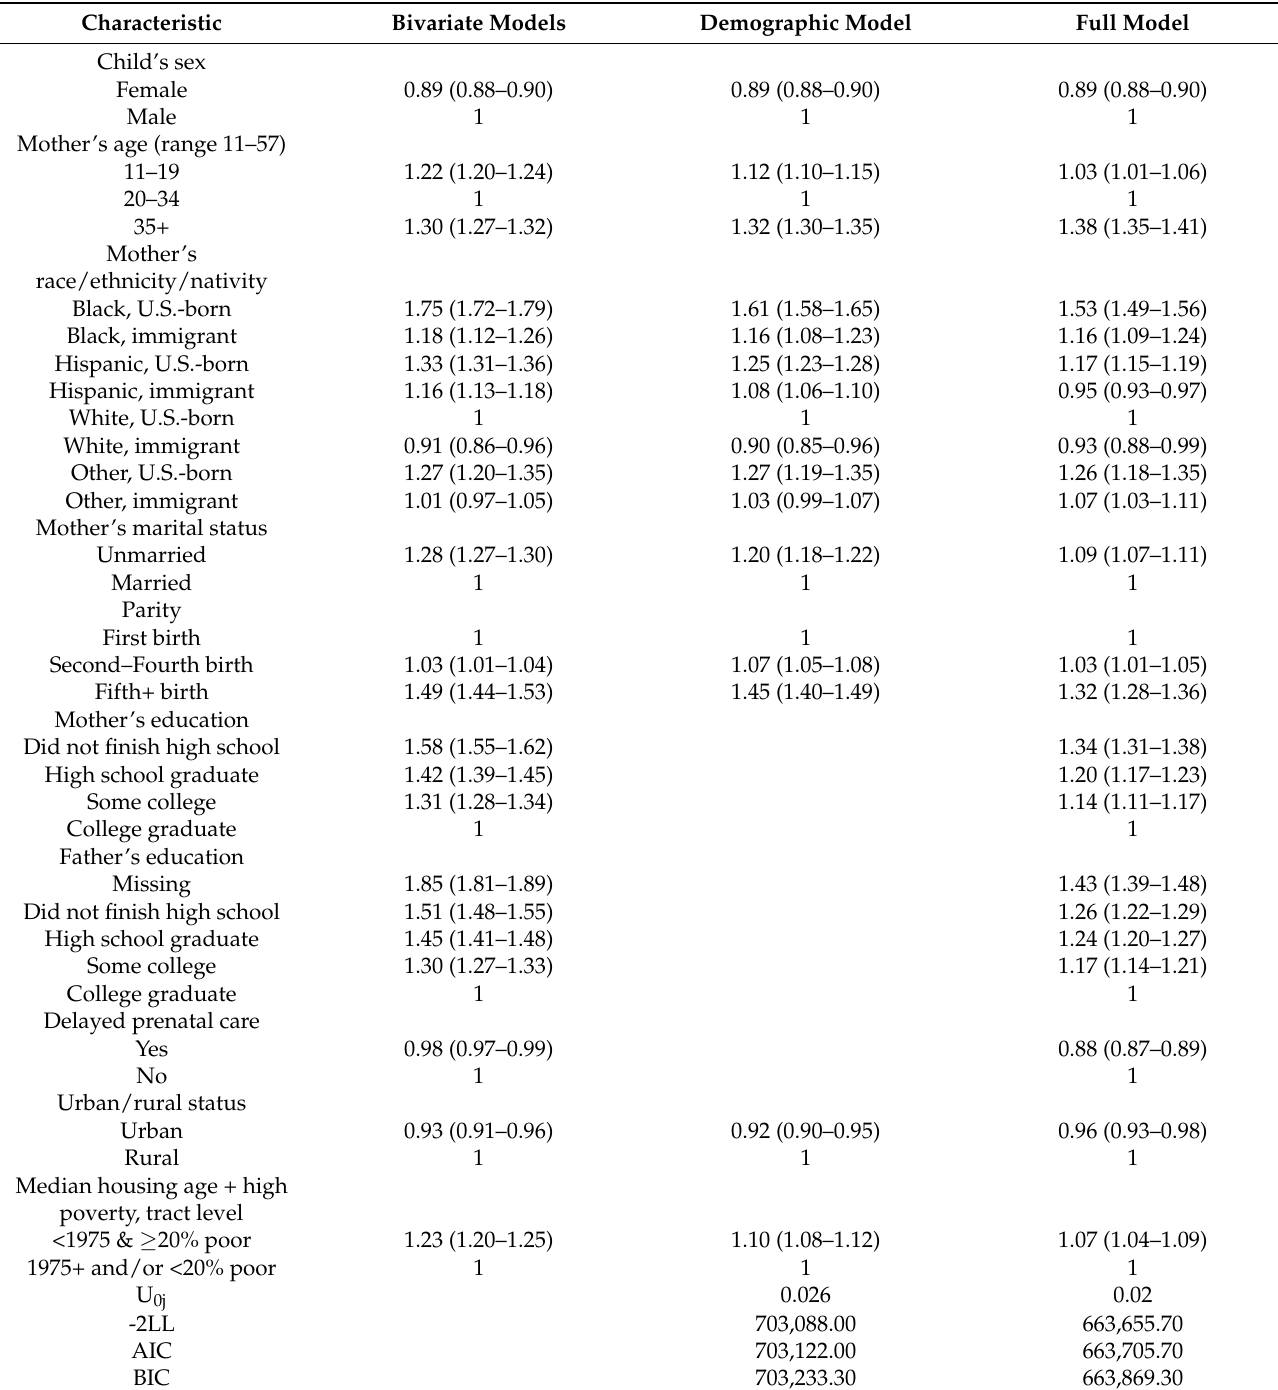
Table 2. Odds and 95% confidence intervals of preterm birth, 2009–2011 Texas natality files, n = 1,040,642.